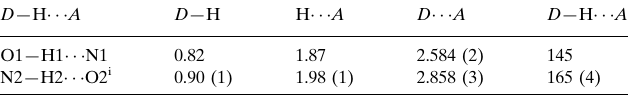
Hydrogen-bond geometry (A˚ , (cid:1)